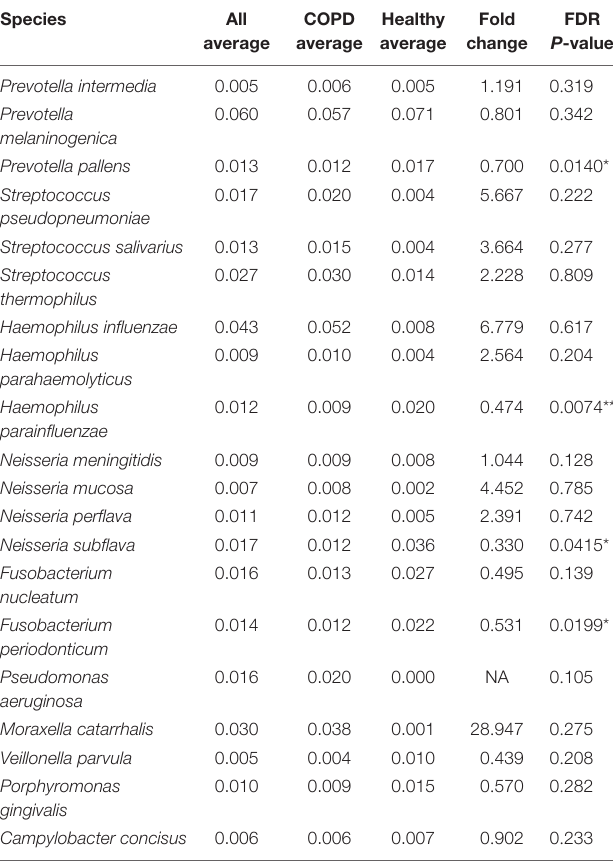
TABLE 2 | The major species-level taxa identified in this study (average relative abundance > 0.005). Species All average